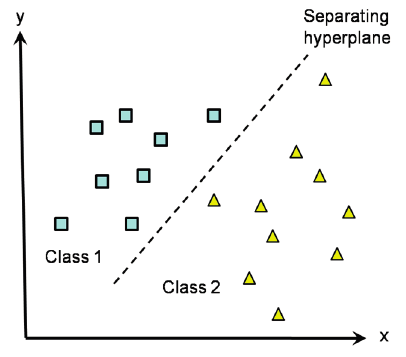
Figure 2. A hyperplane separates two classes in a two-dimensional space ( x and y